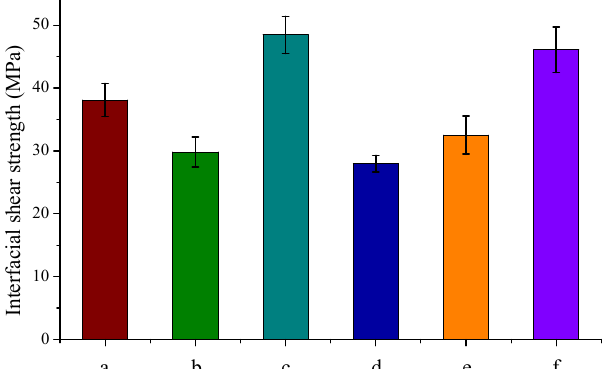
Figure 7. Results of the microdroplet experiments. ( a ) Epoxy resin—unfunctionalized carbon fiber (CF), ( b ) epoxy resin—4-(aminomethyl)benzene functionalized CF, ( c ) epoxy resin—lignin functionalized CF, ( d ) cellulose propionate—unfunctionalized CF, ( e ) cellulose propionate—4-(aminomethyl)benzene functionalized CF, and ( f ) cellulose propionate—lignin functionalized CF.